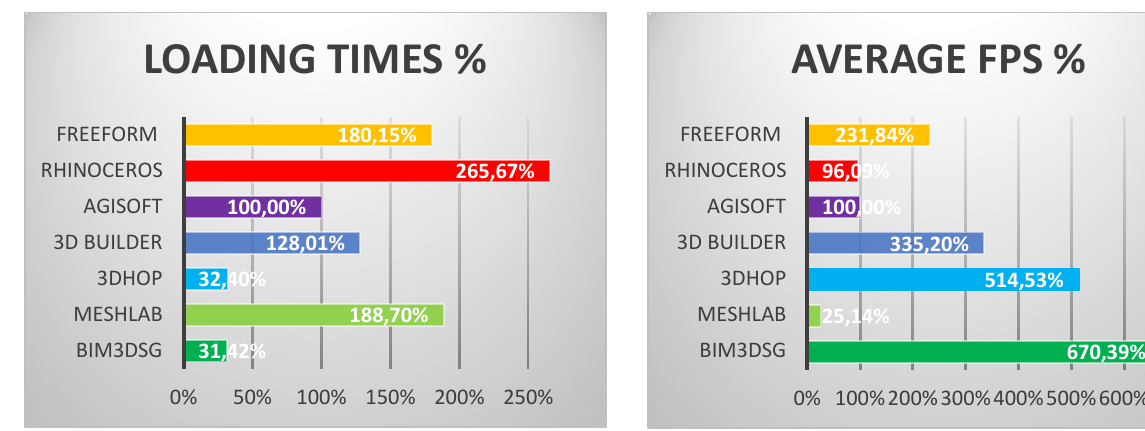
Figure 12: FPS in percent, settings Agisoft as 100%; higher is better